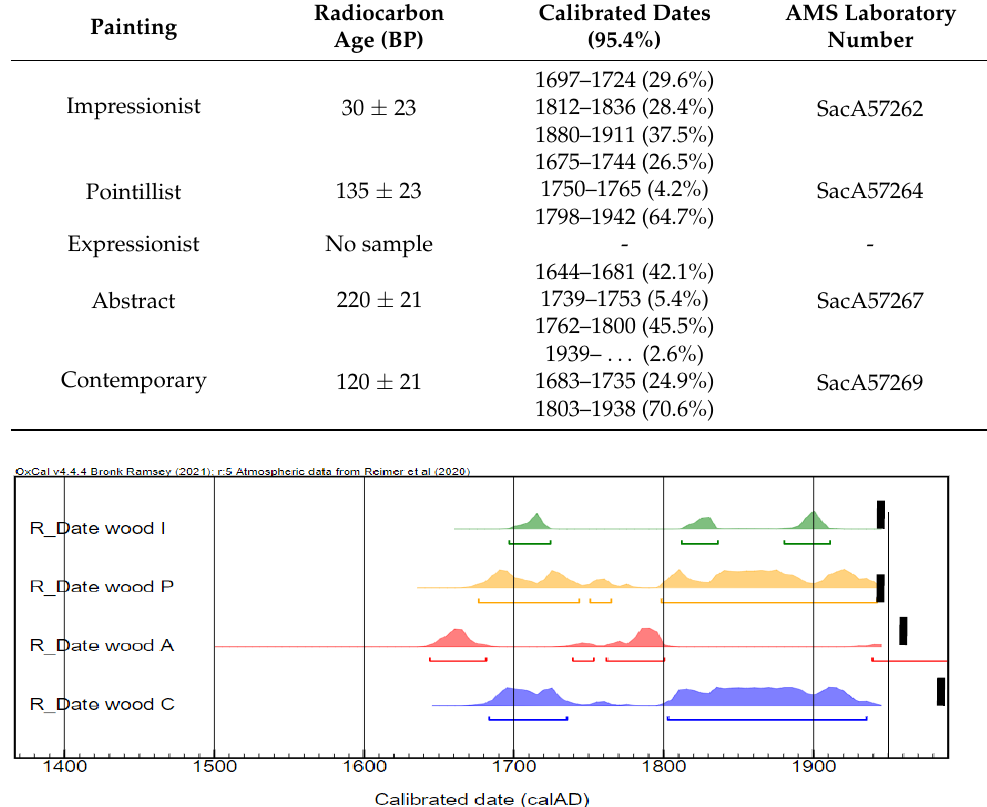
Figure 6. Radiocarbon calibrated dates (shown in calAD) of the wood samples, taken from the stretchers of the Impressionist (I), Pointillist (P), Abstract (A), and Contemporary (C) paintings. The black bars indicate the death of the alleged artists. The radiocarbon calibrated dates were obtained using the atmospheric calibration curve Intcal20 [26].